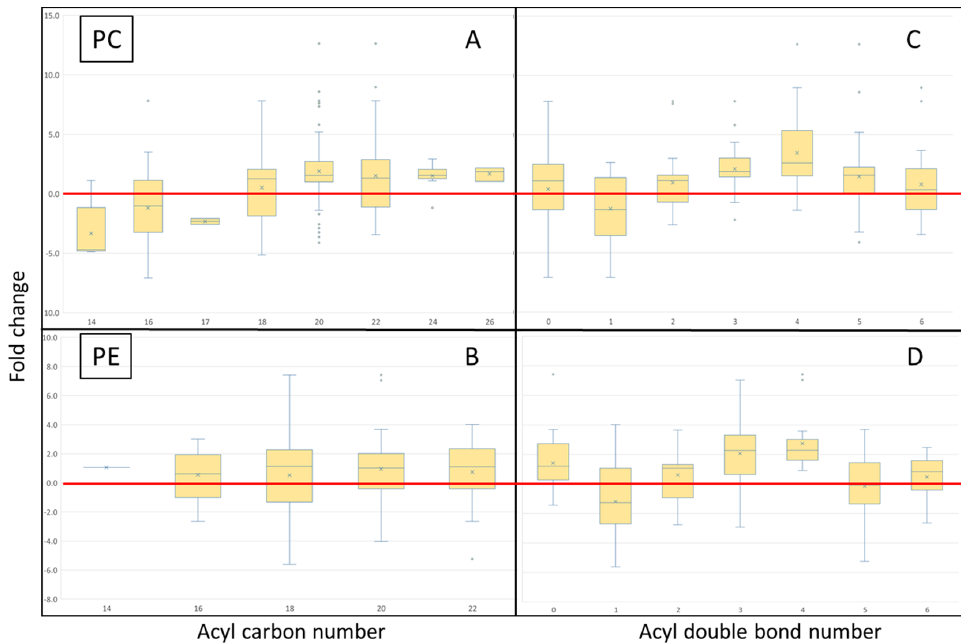
Figure 6. Averaged individual PC and PE bias plots for all tissues and timepoints for both acyl carbon number and number of double bonds, expressed in fold change. ( A ) acyl carbon number in PC, ( B ) acyl carbon number in PE, ( C ) double bond number in PC, and ( D ) double bond number in PE. The GM diet preferentially increased lipids containing acyl chains with 3 and 4 double bonds, comprising 20 and 22 carbons. The control diet preferentially increased lipids containing acyl chains containing 1 double bond, comprising 14 and 16 carbons.